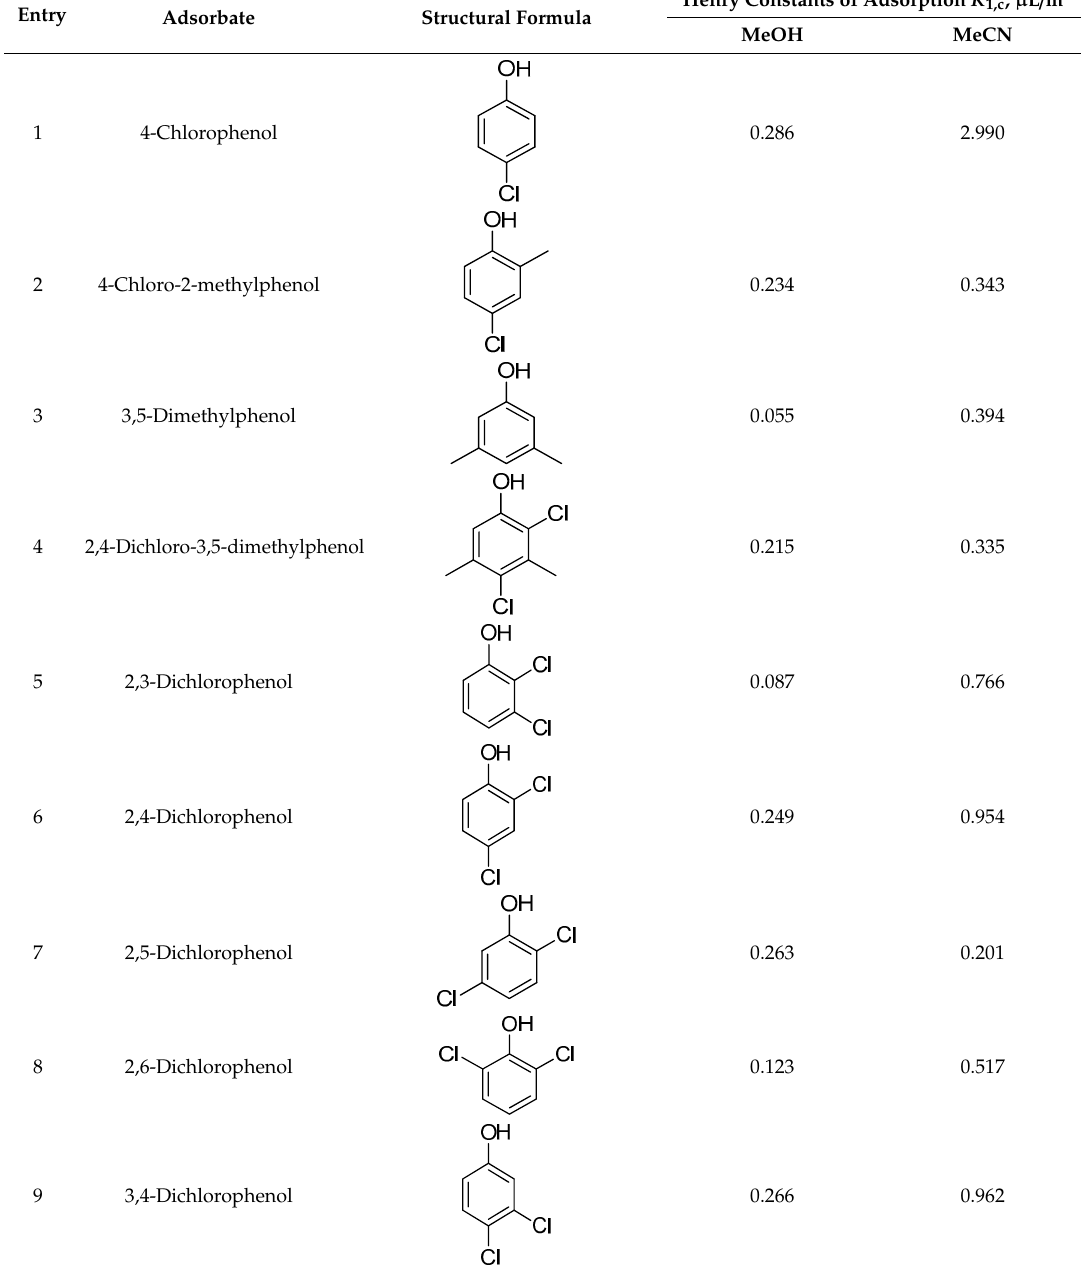
Table 1. Henry constants of adsorption of organic compounds from their solutions in methanol and